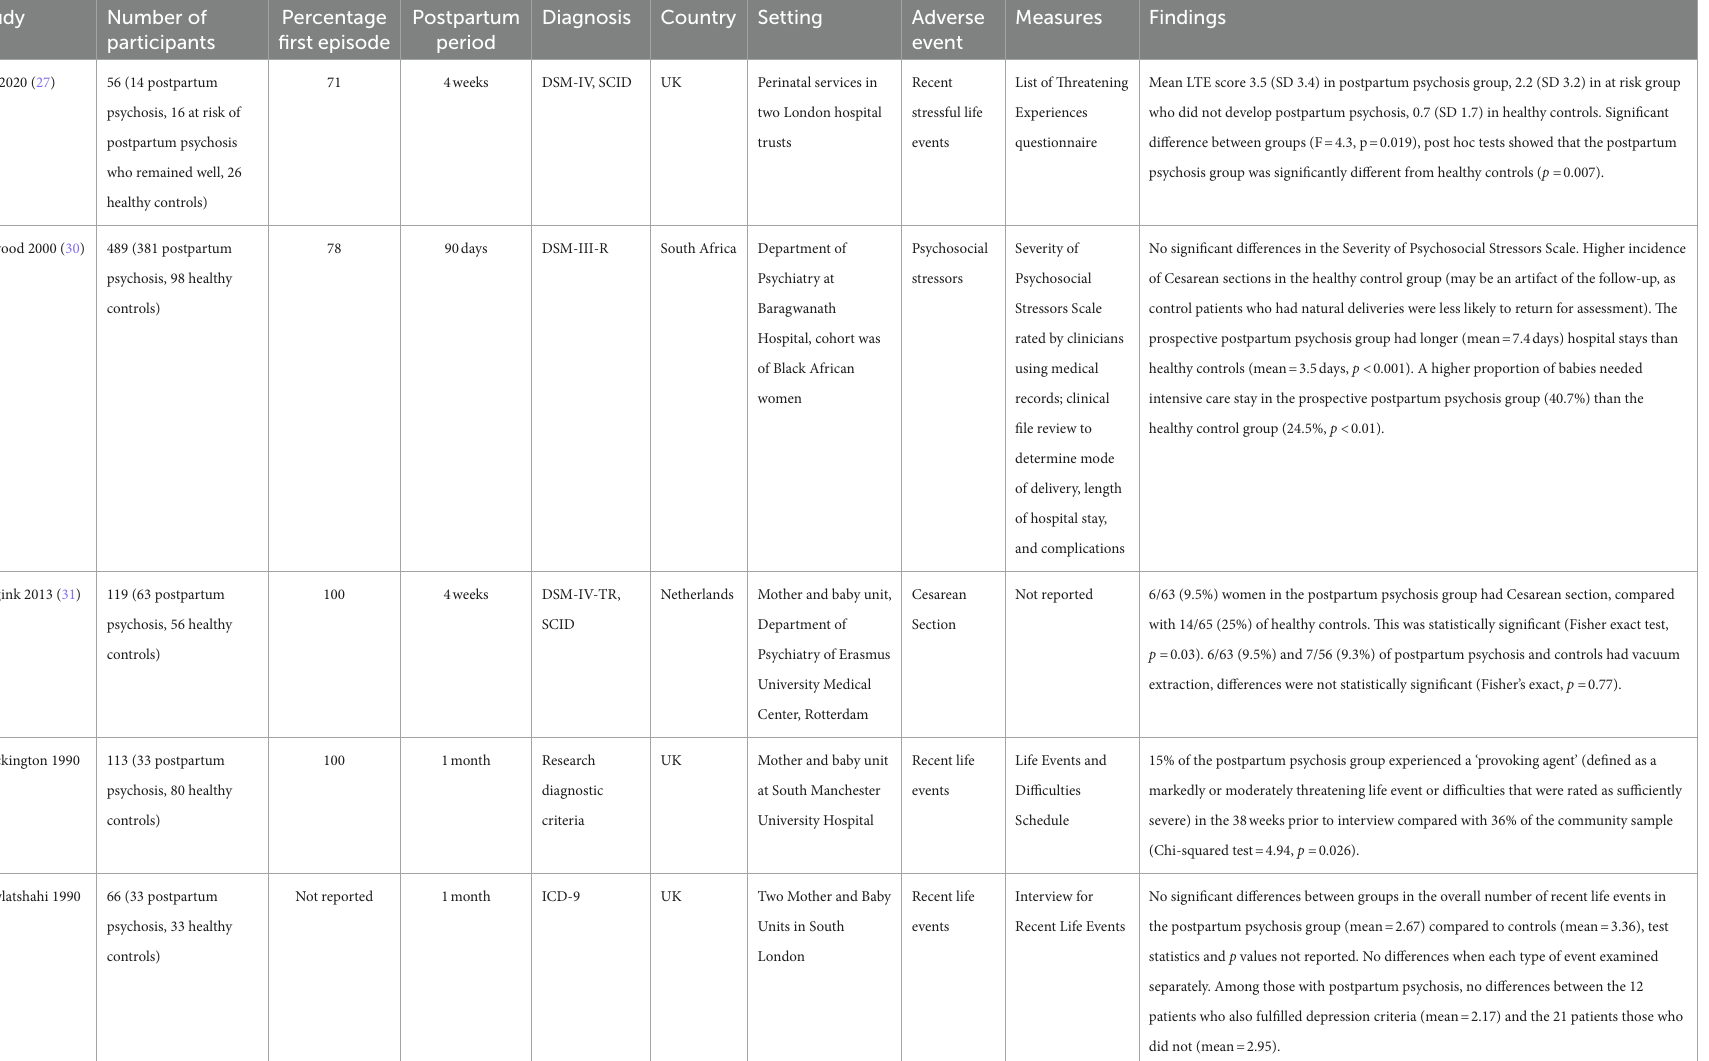
TABLE 1 Summary of case–control studies examining association with onset of postpartum psychosis. Study